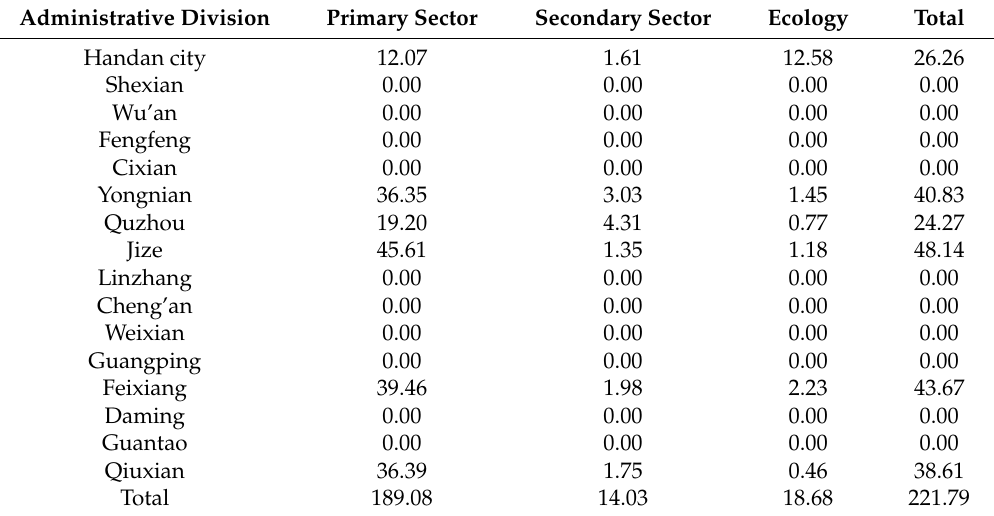
Table 8. Results of Dongwushi reservoir allocated to every user (10 6 m 3 ).